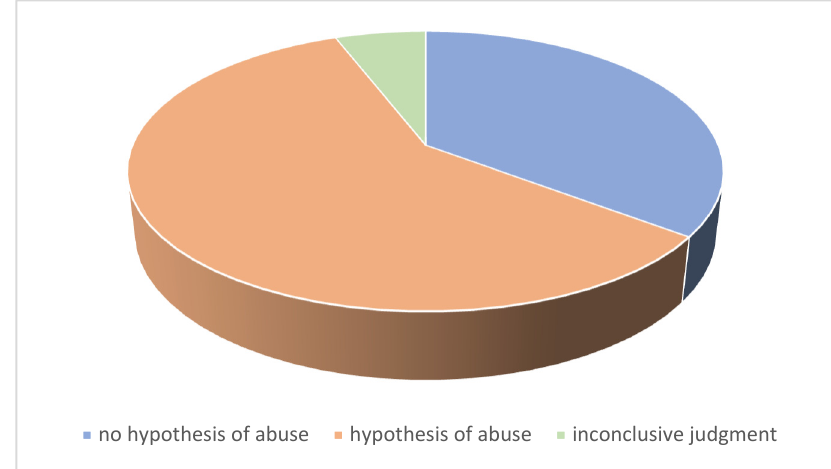
Figure 2. Conclusive medico-legal judgment.